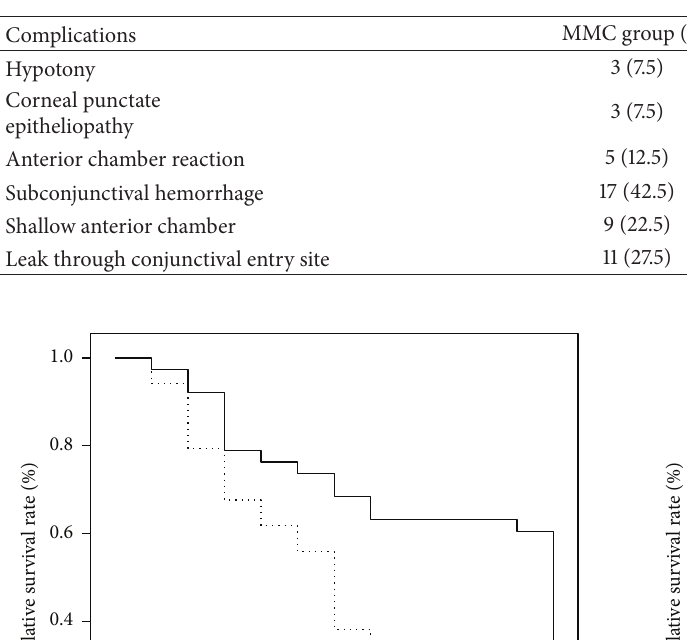
Table 2: Summary of complications that occurred following needle revision.